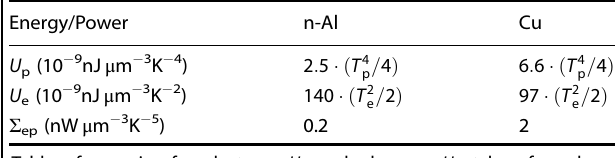
Table of energies for electrons U e and phonons U p taken from low- temperature heat capacities for normal aluminum and copper (https:// nvlpubs.nist.gov/nistpubs/Legacy/MONO/nbsmonograph21.pdf). The electron – phonon coupling constant Σ ep is also